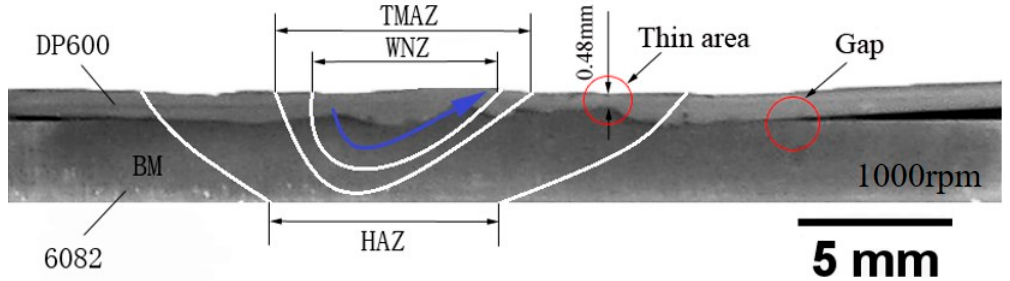
Figure 6. Macroscopic morphology of the cross-section of a dissimilar Al/steel keyhole-free FSSW joint.